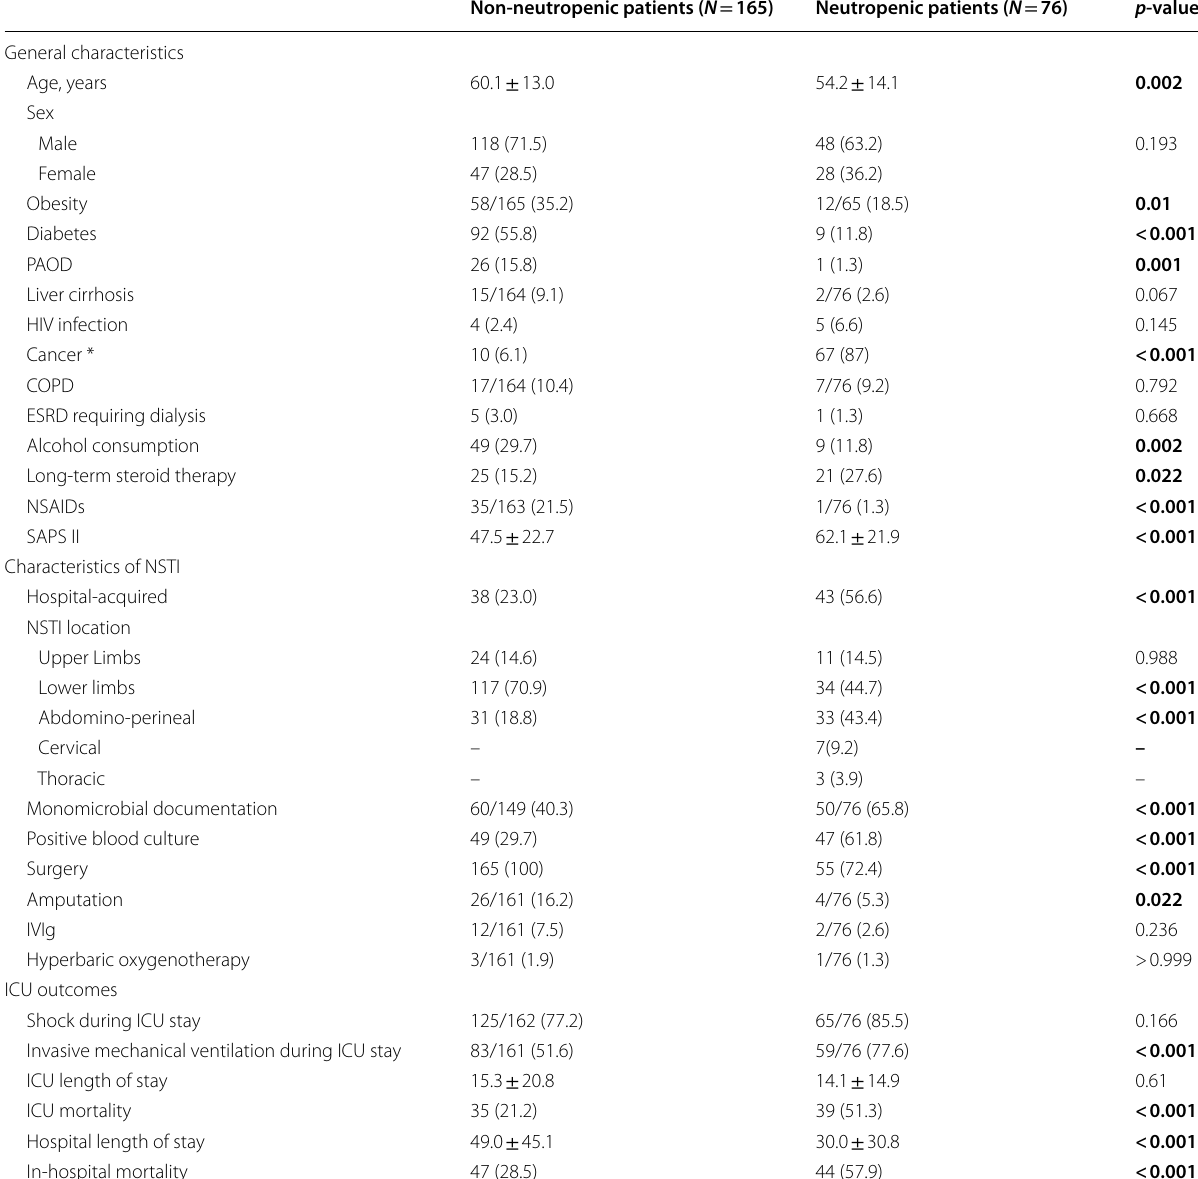
Table 1 Demographics and characteristics of patients with NSTI, according to the presence of